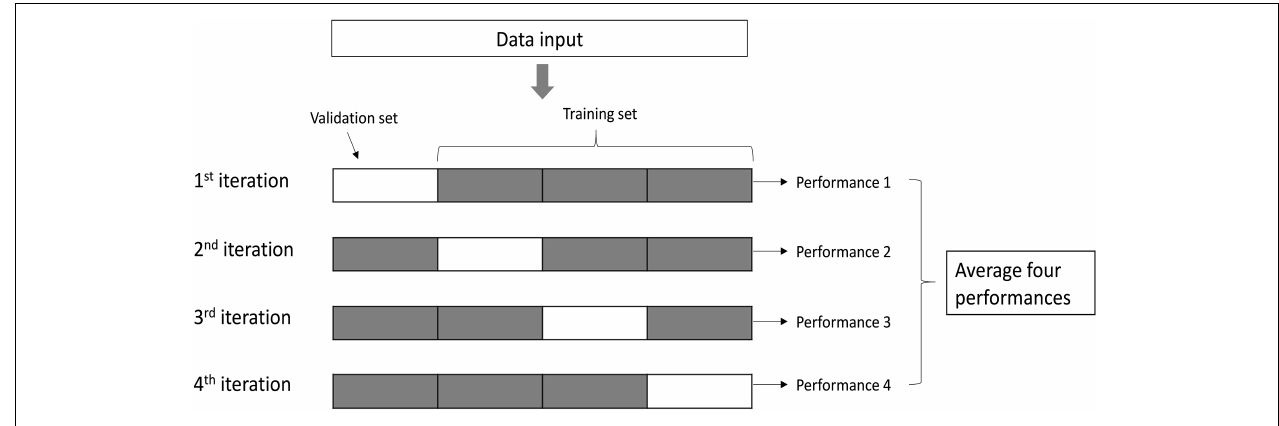
FIGURE 1 | Flow chart of the four-fold